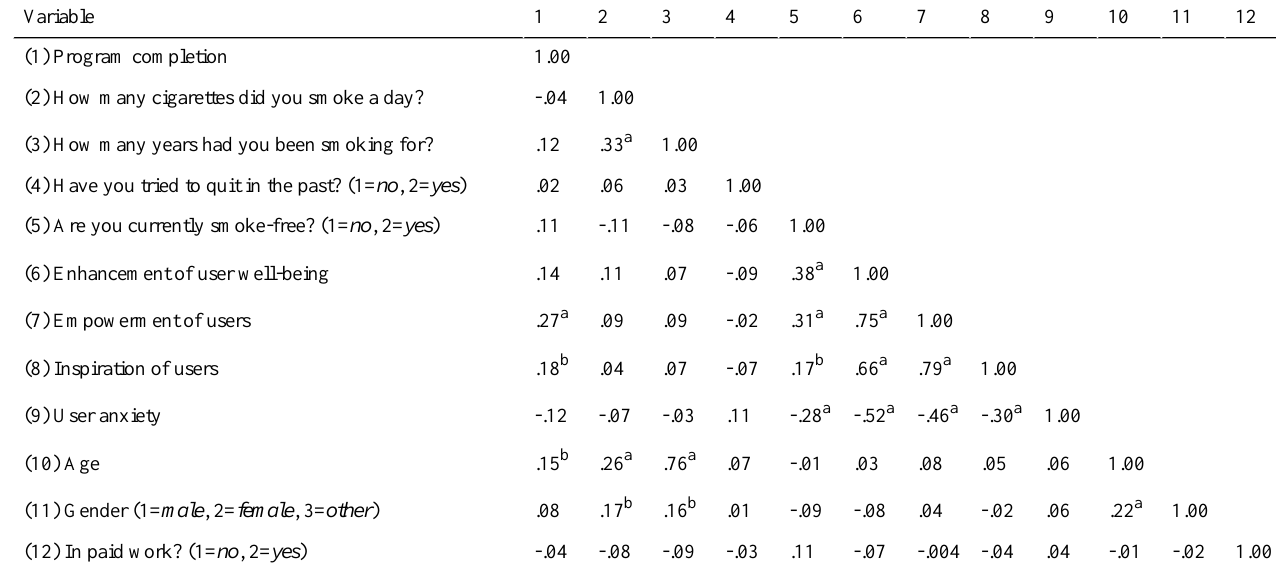
Table 3. Correlation